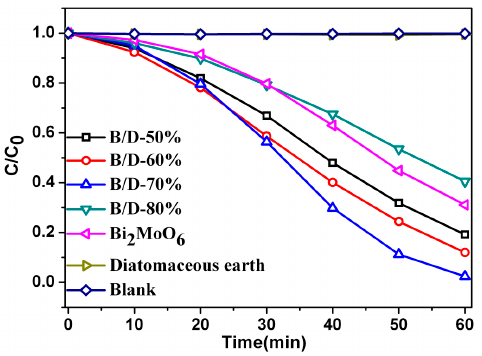
Figure 6. Degradation efficiency of RhB for Bi 2 MoO 6 , B/D-50%, B/D-60%, B/D-70%, B/D-80%, and diatomite.